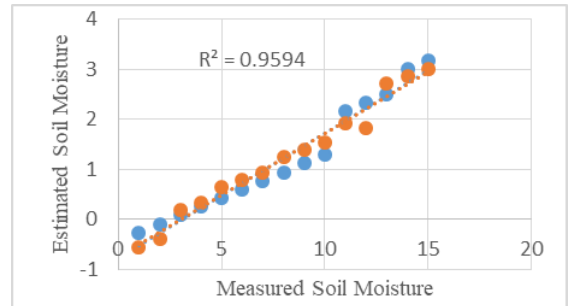
Figure 7. Distribution of soil moisture content measured and estimated from the application of the